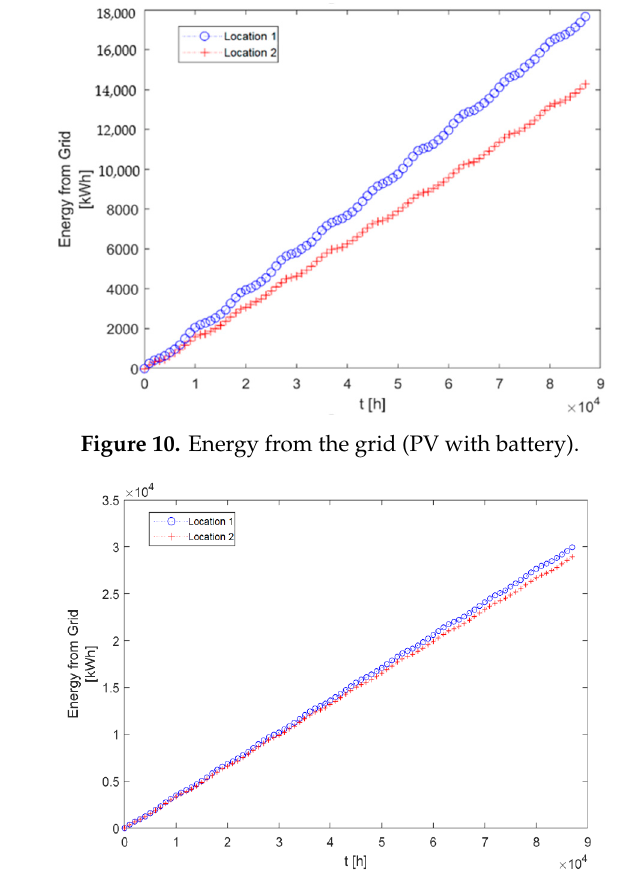
Figure 11. Energy from the grid (PV without battery).